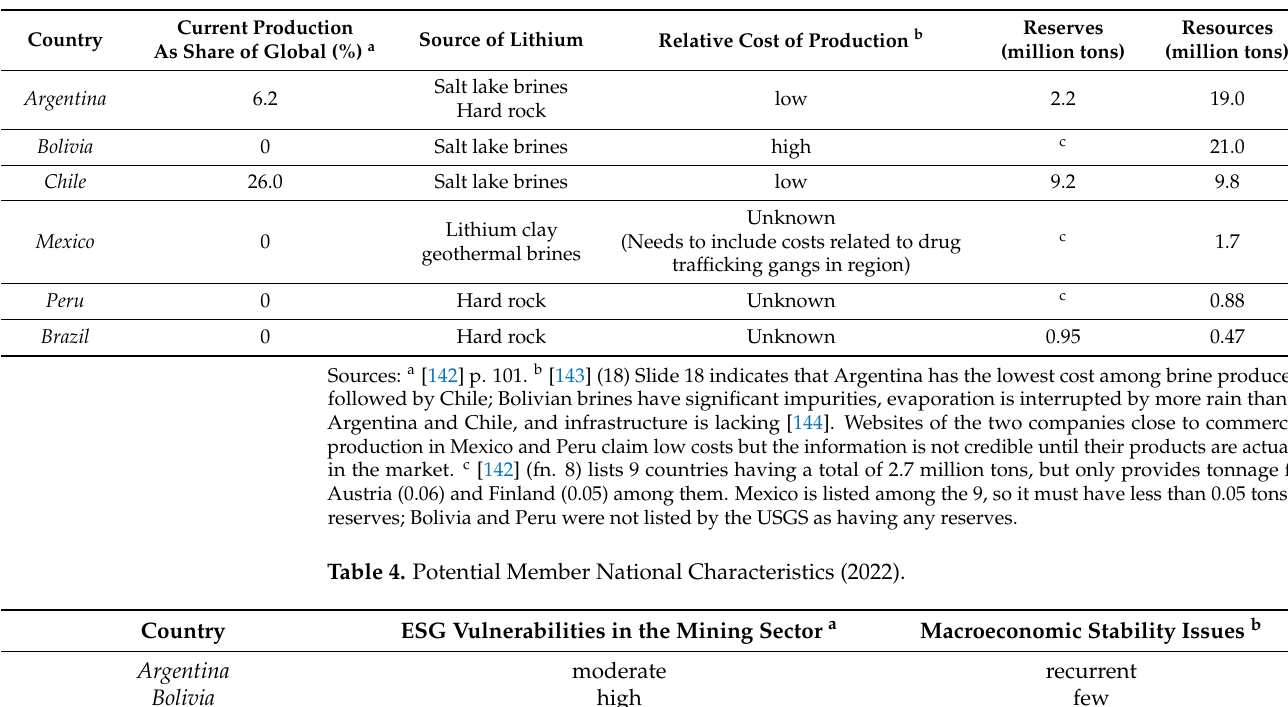
Table 3. Potential Member Lithium Characteristics (2022 unless otherwise noted).